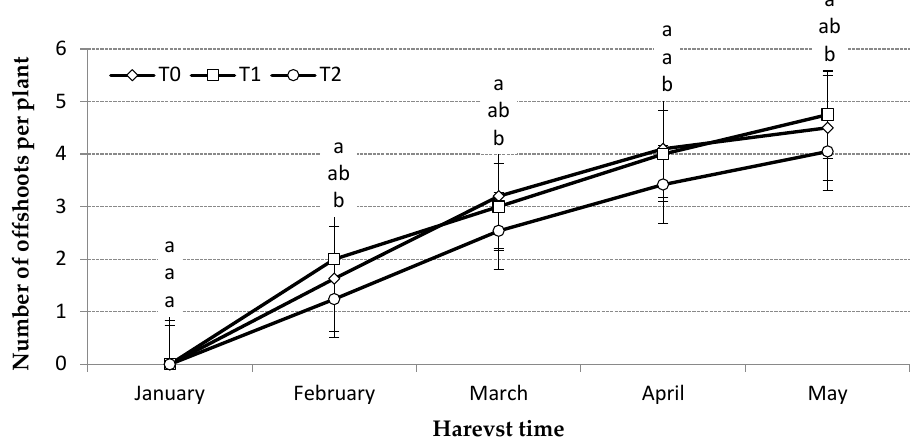
Figure 3. Number of offshoots formed according to the cuttings type used for the artichoke vegetative propagation. Within the same period, data were analyzed by ANOVA, and values with no letter in common are significantly different at p < 0.05, according to Tukey HSD Test. Standard errors are reported. T0: summer ovoli; T1: spring offshoots nursery’s cuttings forced to pass a vegetative rest period by stopping irrigation; T2: spring offshoots nursery’s cuttings not forced.